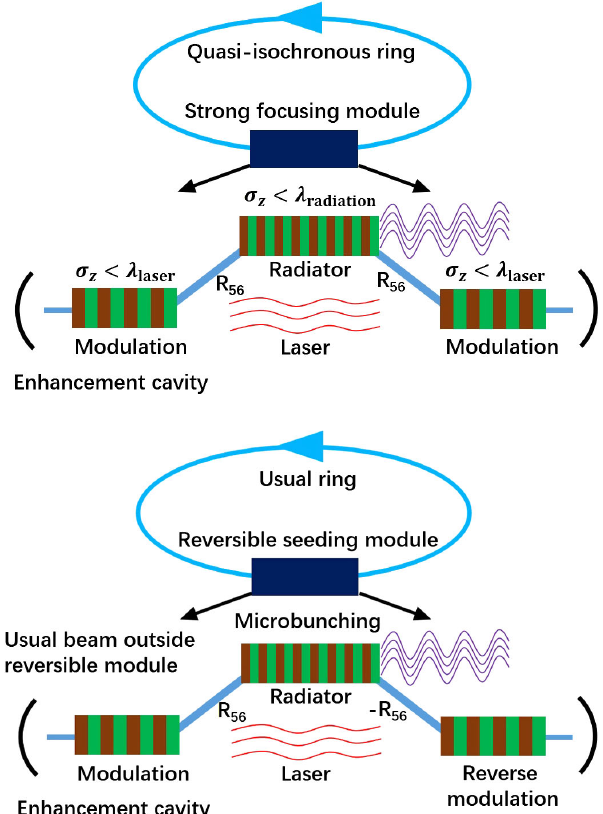
FIG. 2. Schematic layouts of longitudinal strong focusing SSMB (top) and reversible seeding SSMB